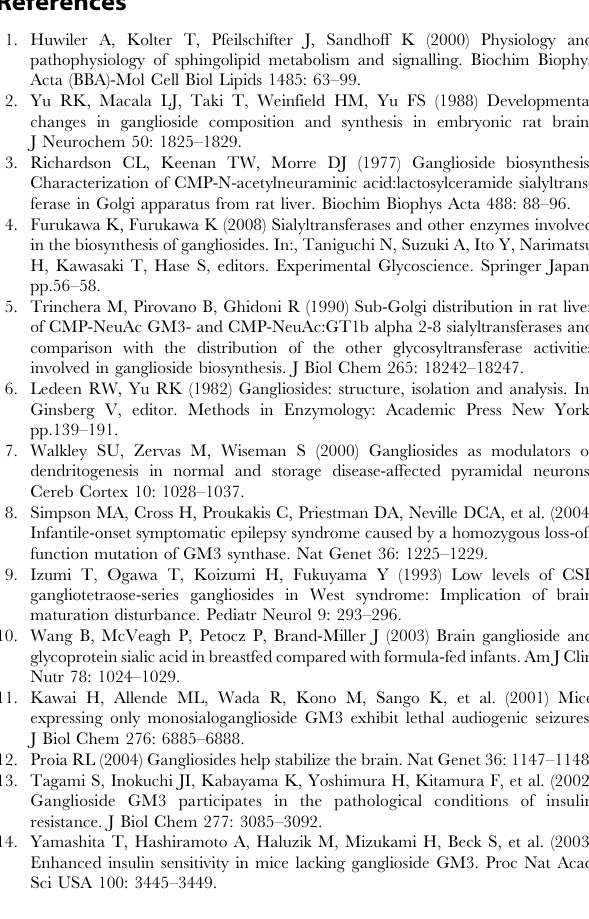
somes from bovine and ovine